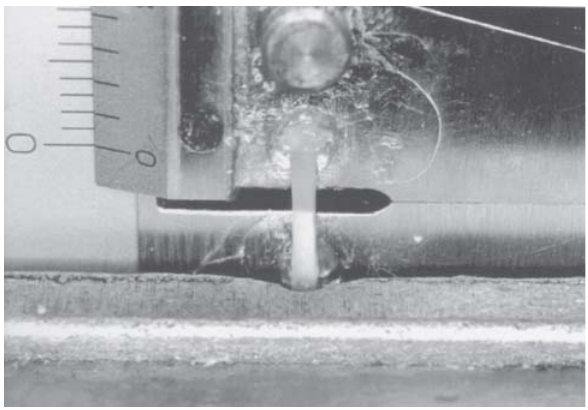
FIGURE 6- Sample fixed to the calliper mounted in testing machine